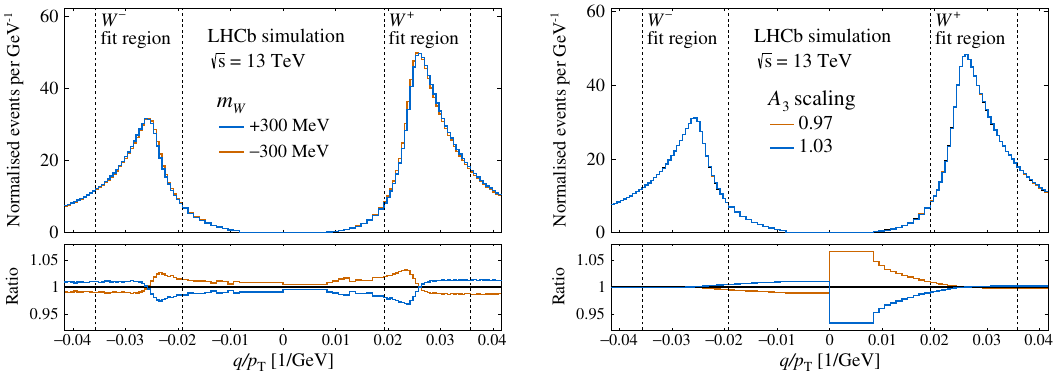
ranges that are included in T